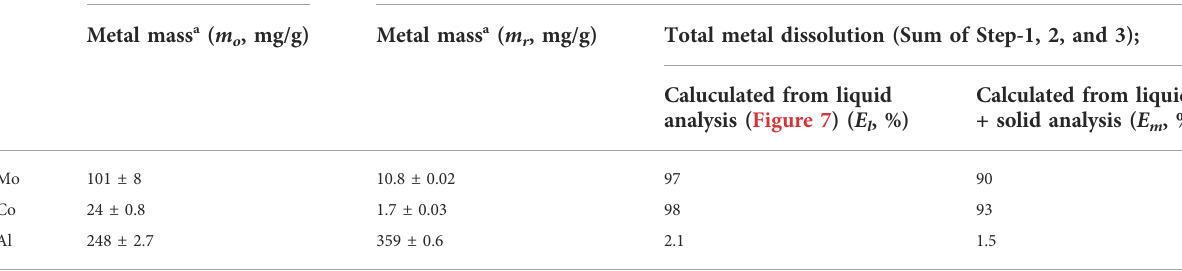
TABLE 2 Total metal dissolution calculated based solely on the liquid analysis or the combination of liquid and solid